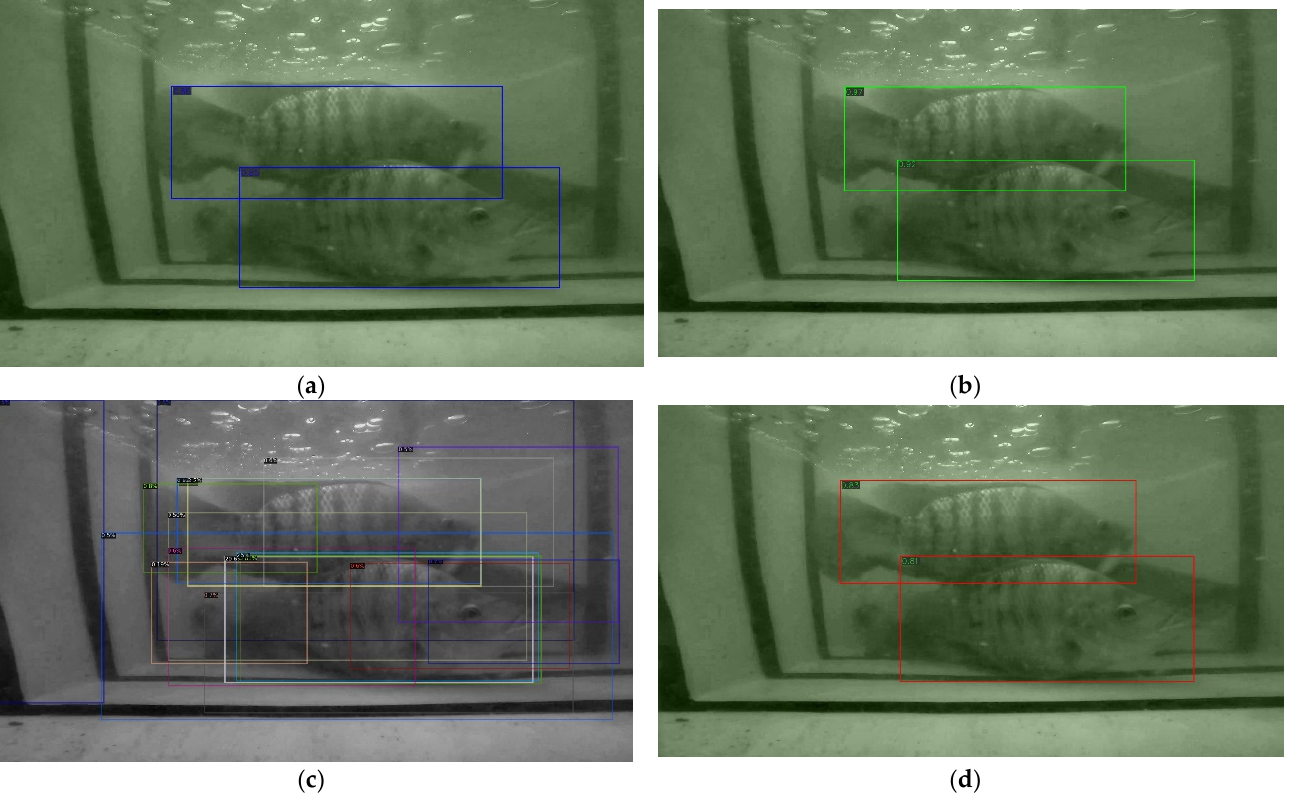
Figure 9. Sample of multiple Tilapia overlapping. ( a ) Faster R-CNN: model detected a Tilapia with 0.86 and 0.85 probability scores from left to right; ( b ) Mask R-CNN: model detected a Tilapia with 0.97 and 0.92 probability scores from left to right; ( c , d ) RetinaNet: model drew 19 bounding boxes with the highest, average, and standard deviation of probability scores at 0.83, 0.17, and 0.25, respectively.